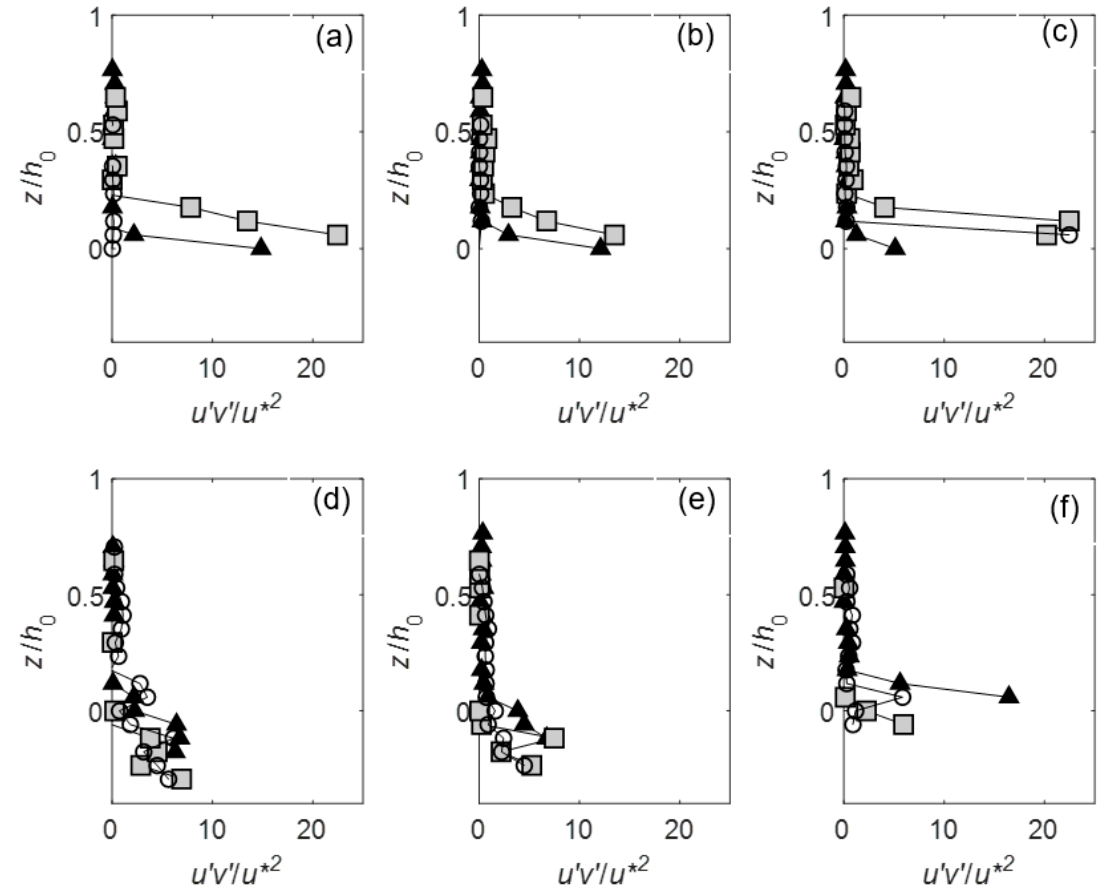
Figure 7. Comparison of Reynolds shear stress < u ’ v ’>/ u* 2 for three different verticals, ( a , d ) y/D = 0.833 , ( b – e ) y / D = 1.5, and ( c – f ) y / D = 4.2, for fixed (top rows) and mobile beds (bottom rows). Symbols are the same symbols as in Figure